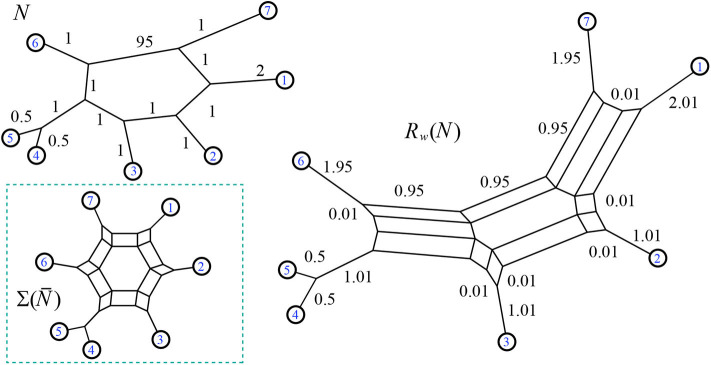
Example of the function Rw which takes a weighted phylogenetic network and outputs the split network associated to its resistance distance. Neighbor-net can be run on input dNR, or the results of Theorem 3.2 can be used: for instance the value 0.95 for the split {1, 2, 3, 7}|{4, 5, 6} is found by 95(1)/(95+1+1+1+1+1). HeredNR=(3.99,4.96,6.41,6.41,6.84,3.99,2.99,4.46,4.46,4.91,3.96,3.49,3.49,3.96,4.91,1,3.49,6.34,3.49,6.34,6.75).